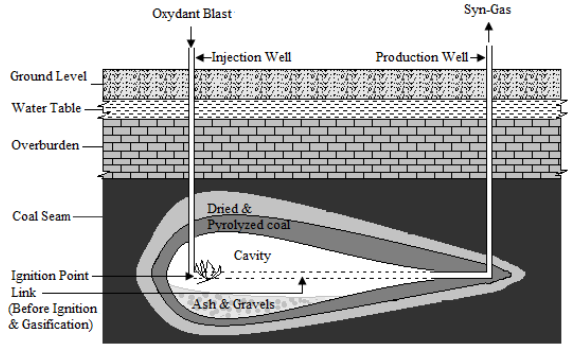
Figure 1. Schematic diagram (not to scale) of the UCG process for linked vertical wells (LVW).